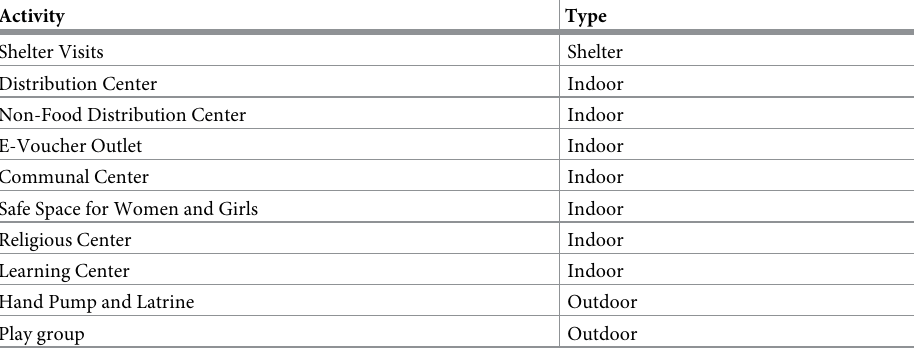
Table 1. Classes of locations that simulated PoCs can visit in the